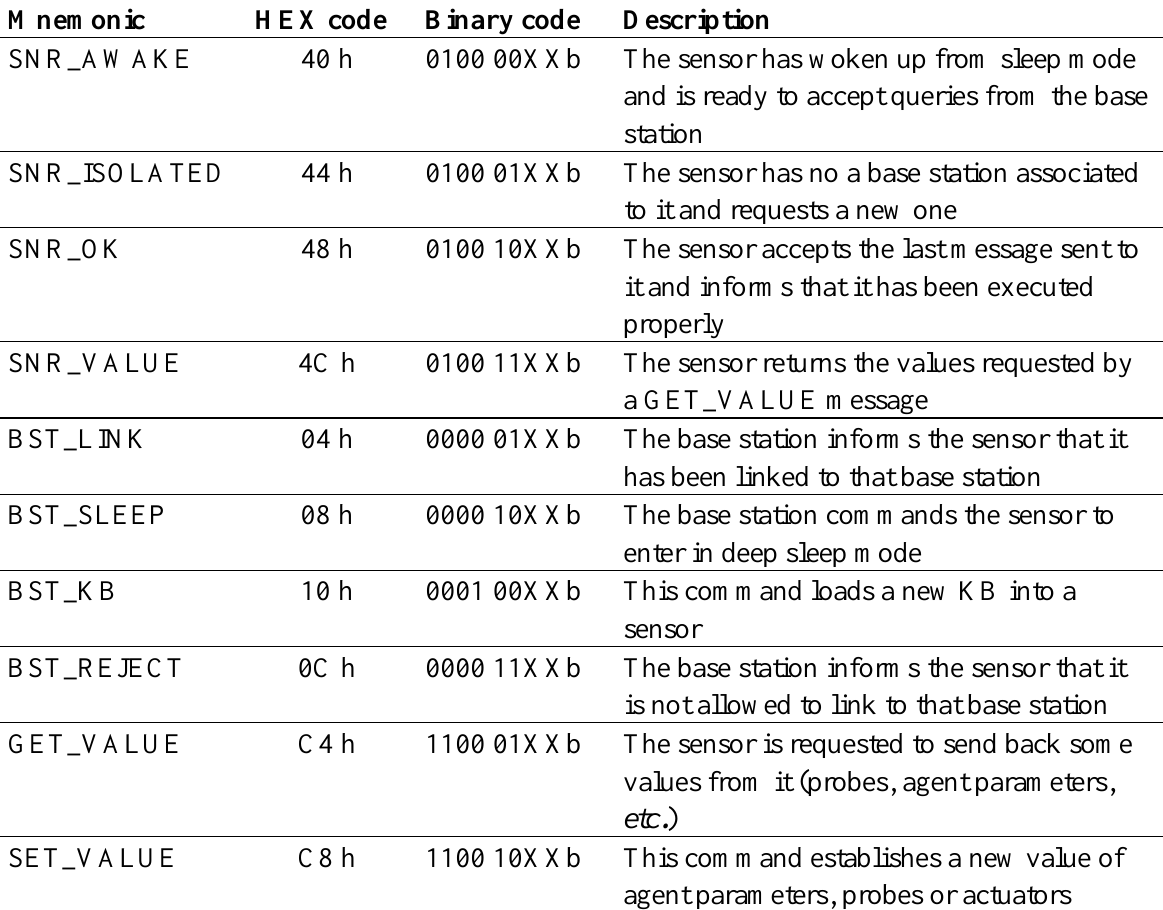
Table 1. Protocol